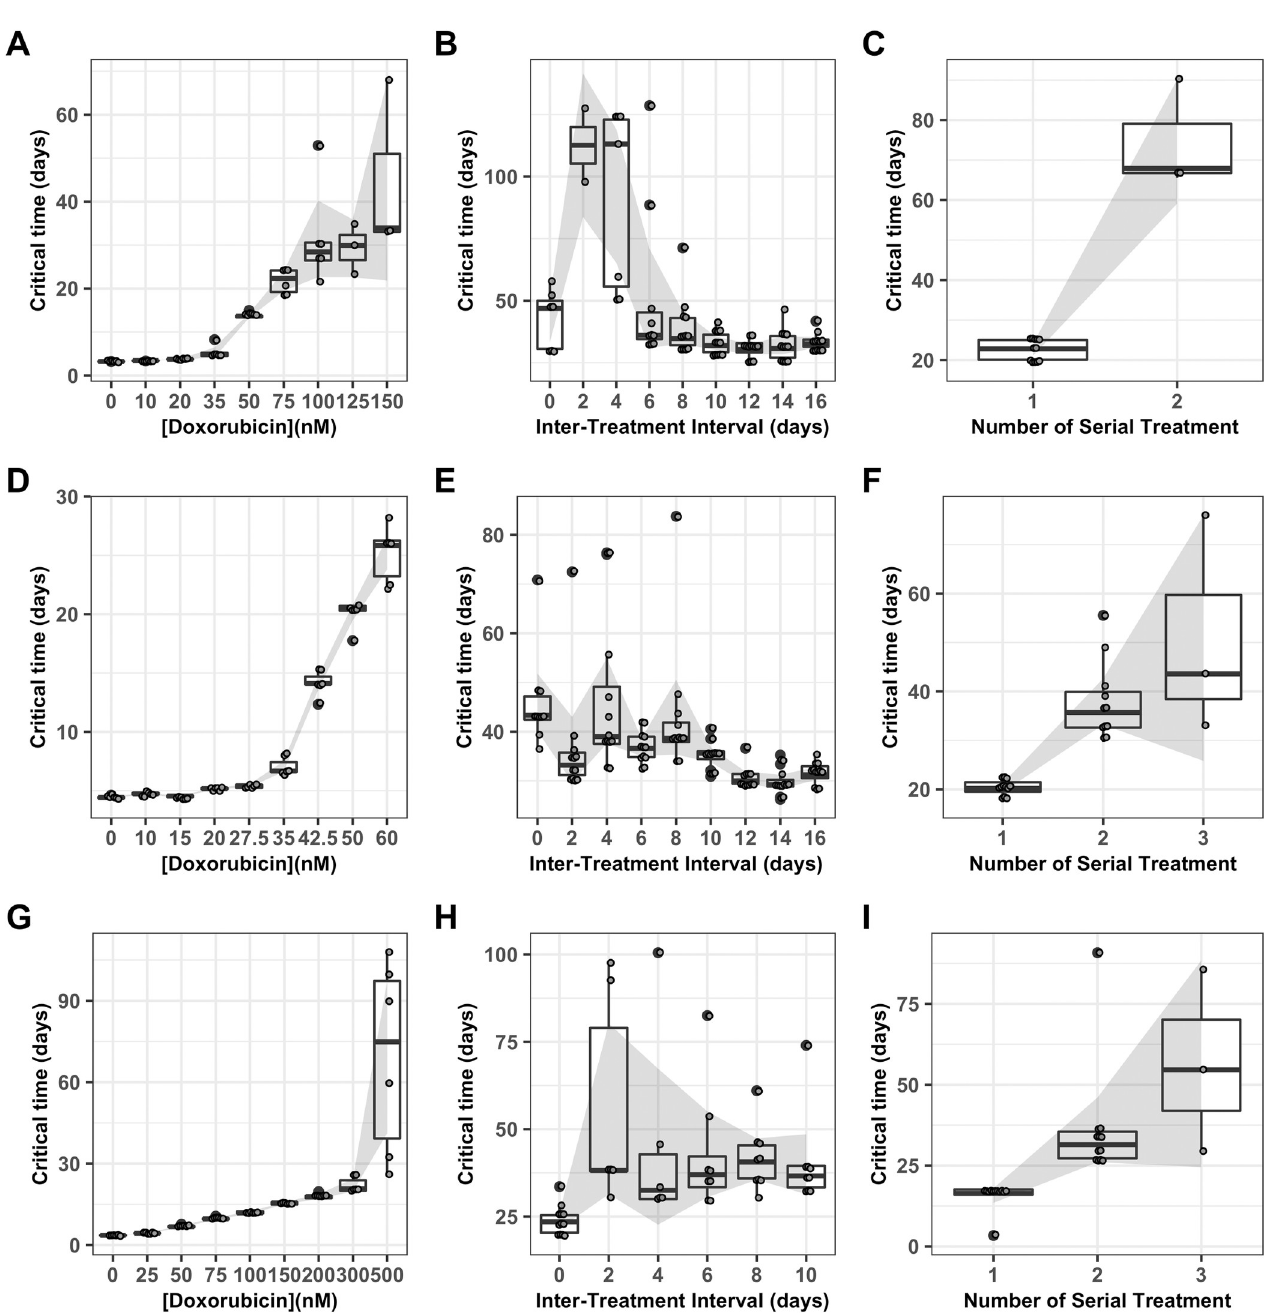
Fig 7. Critical time projections. Critical time is estimated based on the best fit to model 1 for each replicate culture in the MCF7 cell lines and shown as a Tukey box-and-whiskers plot as doxorubicin concentration varies in the MCF7 cell line (A), the BT474 cell line (D), and the MDA-MB-231 cell line (G), as the interval between two 24 hour doxorubicin exposures varies at 75 nM in the MCF7 cell line (B), at 35 nM in the BT474 cell line (E), and at 200 nM in the MDA-MB-231 cell line (H), and as the number of sequential 24 hour doxorubicin exposures varies at a two day interval and 75 nM in the MCF7 cell line (C), at a zero day interval (continuous exposure) and 35 nM in the BT474 cell line (F), and at a two day interval and 200 nM in the MDA-MB-231 cell line (I). The number of replicates in each group varies between 3 and 12; all replicates in which recovery is observed are included. The 95% confidence interval on the mean is shown by the shaded